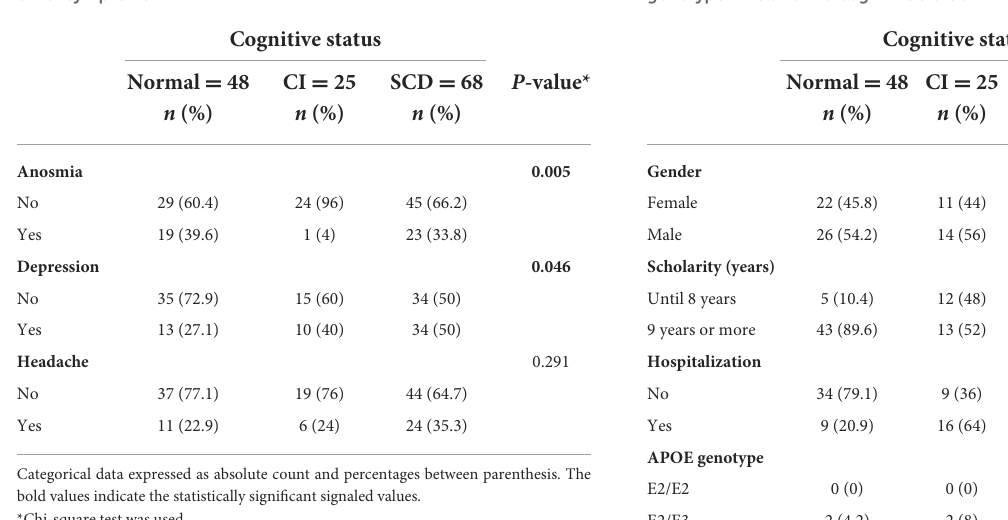
TABLE 5 Comparison between cognitive impairment in relation to other symptoms.